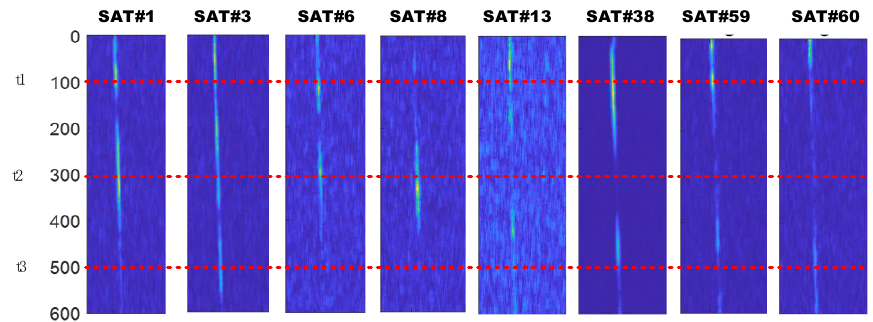
Figure 17. Comparison of the echo intensity of 8 satellites. The intercepted signal energy distribution of the eight satellites is drawn as a two-dimensional diagram, as shown in Figure 18. The RCS of different angles of the car is different, so the echo signal intensity is also different. The echo signal intensity of the 38th satellite is the largest, and the echo signal intensity of the 13th satellite is the smallest. This is mainly due to the fact that the azimuth angle and elevation angle of the satellites are different, therefore the bistatic RCS formed by the car is different.